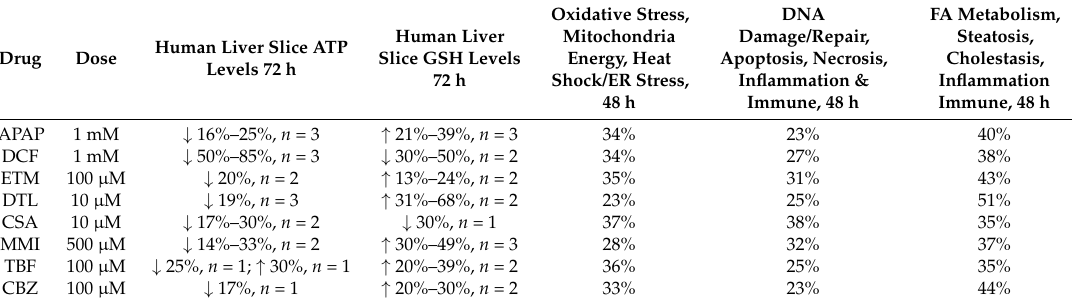
Table 5. Summary of oxidative stress and mitochondria function markers, ATP and GSH levels ( ↑ = increase, ↓ = decrease) plus gene expression pathways affected by each drug. Gene categories listed in each column represent the percent of total gene expression changes by each